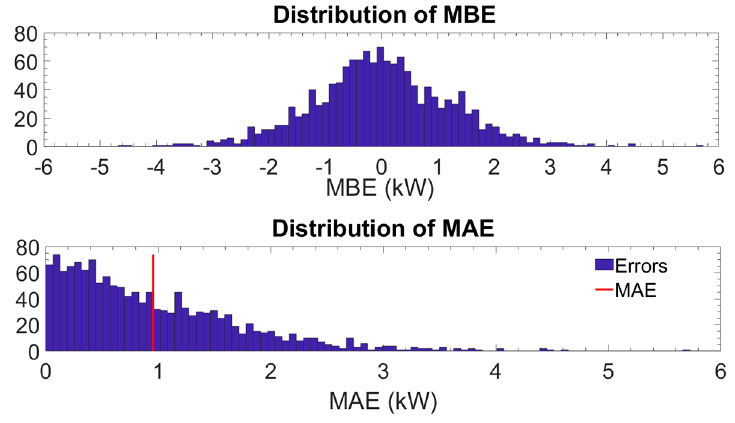
Figure 6. Distribution of MBE and MAE in the forecasting period.